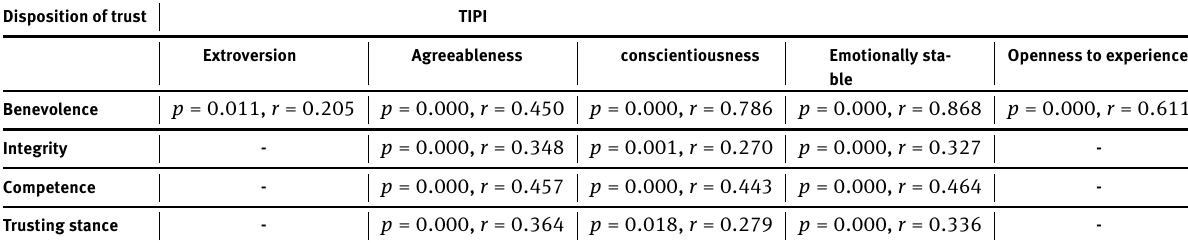
Table 2: The Cross-tabulation between the participants’ disposition of trust and participants’ personality traits: agreeableness, conscien- tiousness and emotional